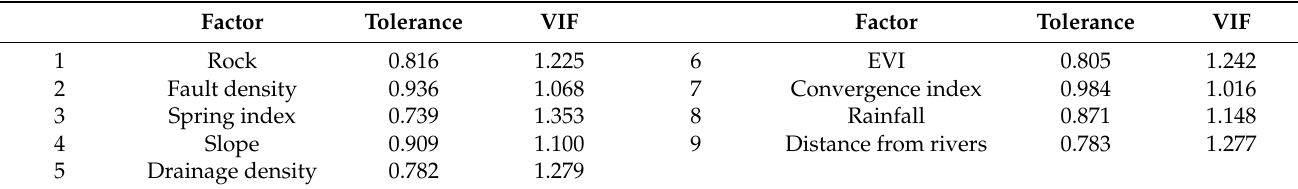
Table 5. Collinearity assessment results for the